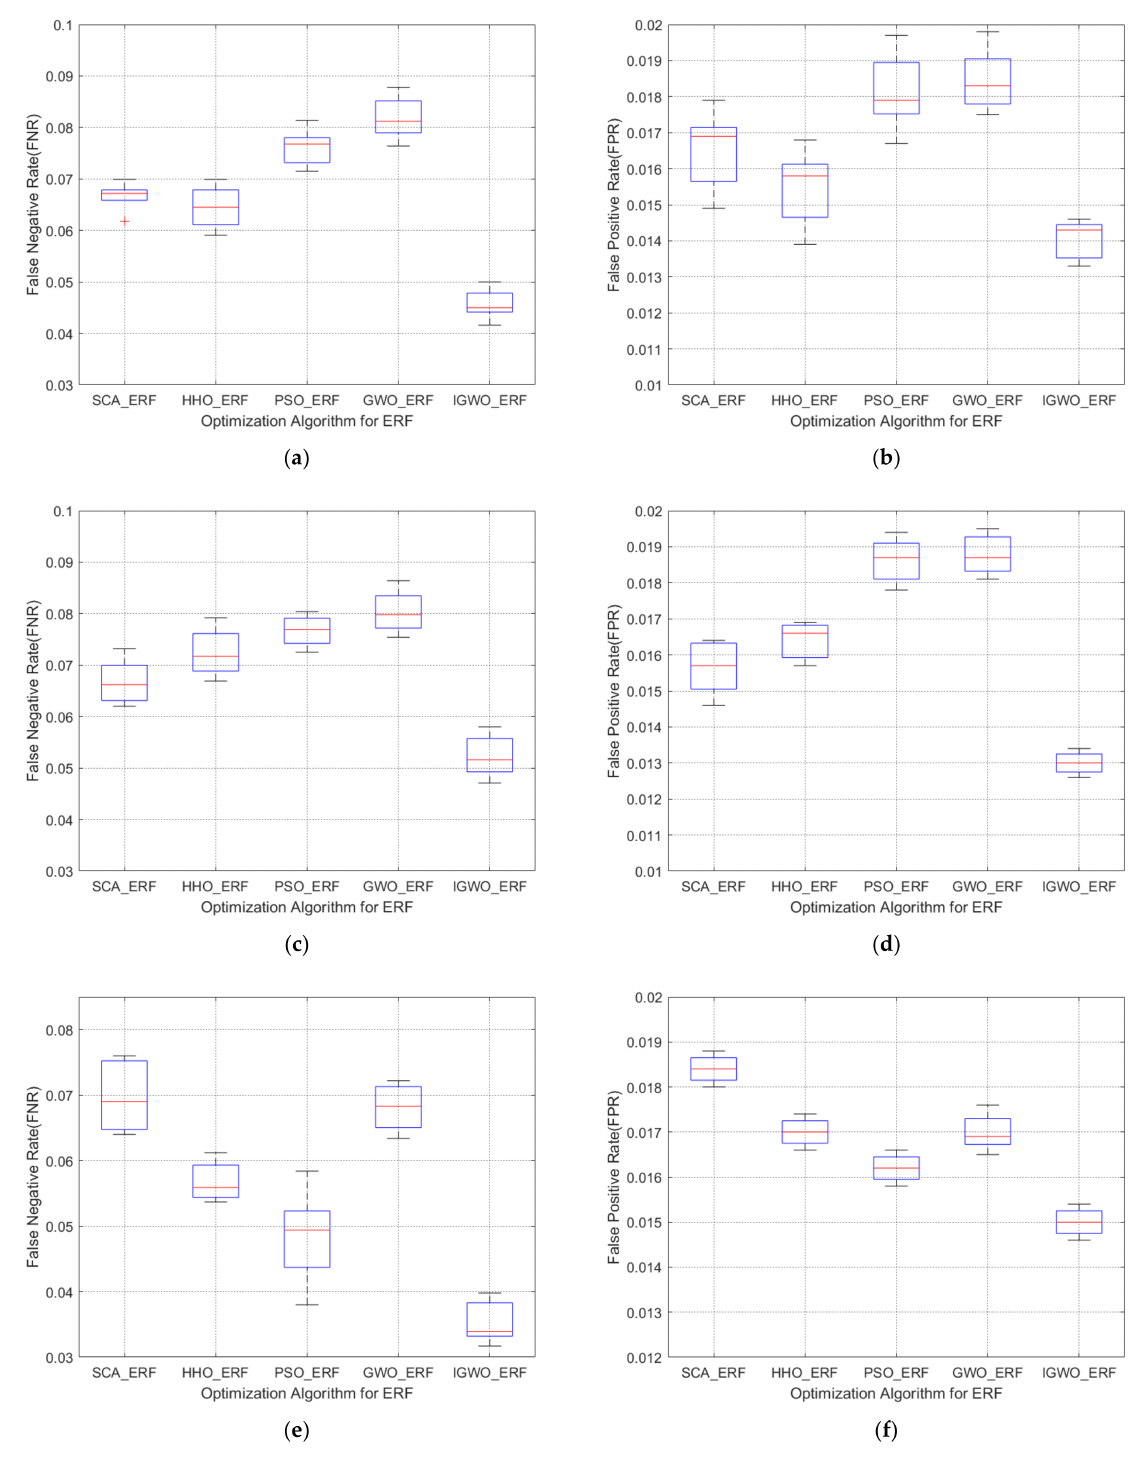
Figure 6. ( a ) The FNR box diagram of the supercapacitor fault; ( b ) the FPR box diagram of the supercapacitor fault; ( c ) the FNR box diagram of electric pitch axle box fault; ( d ) the FPR box diagram of electric pitch axle box fault; ( e ) the FNR box diagram of electric pitch main power; and ( f ) the FPR box diagram of electric pitch main